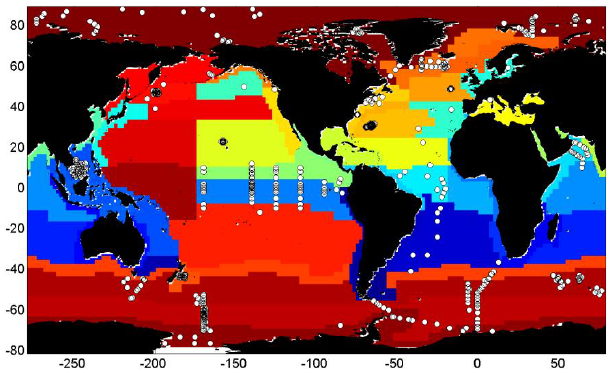
Fig. 4: Histogram of datapoints presented in table 1 and published since 1987. The star 254 Figure 4. Histogram of datapoints presented in Table 1 and pub- indicates the year 2004 when VERTIGO study was undertaken. 255 lished since 1987. The star indicates the year 2004 when the VER- TIGO study was